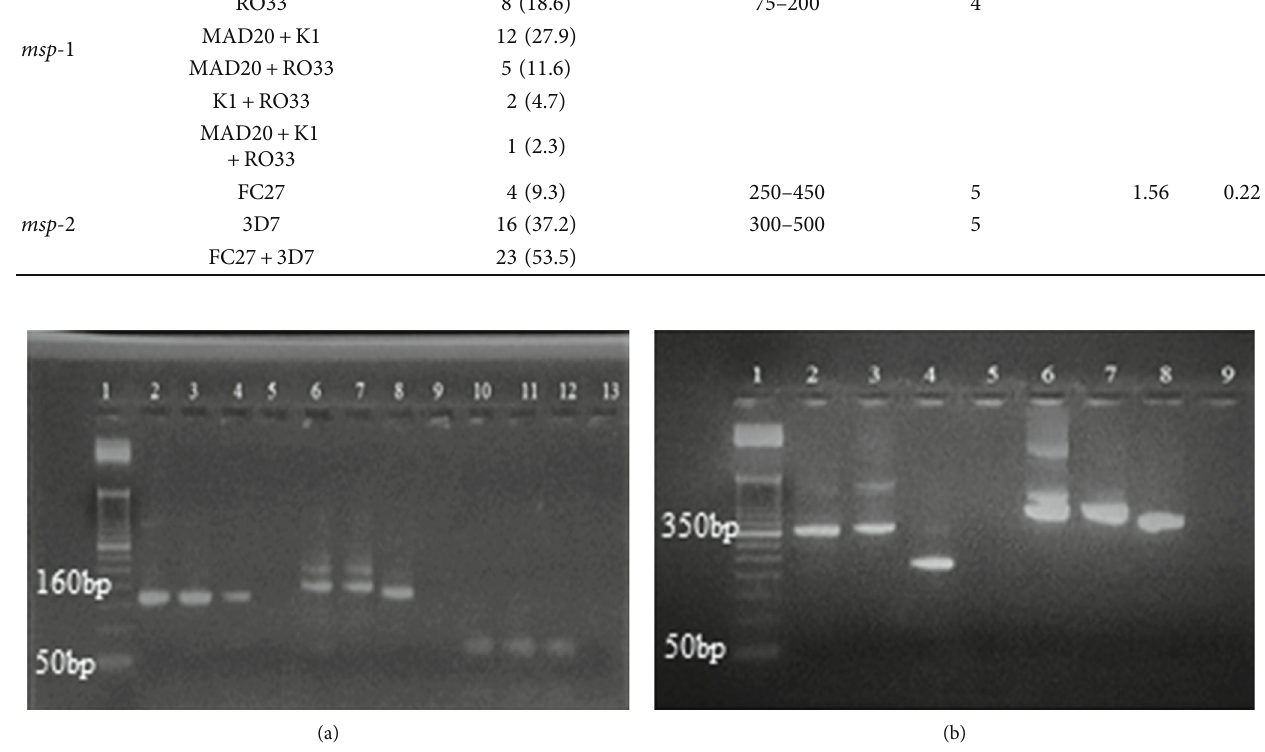
Figure 1: Gel electrophoresis of MSP allelic families. (a) Alleles of the msp -1 gene showing lane 1 (L1) 50bp DNA ladder; positive samples: L2 and L3 for MAD20 (160bp), L6 and L7 for K1 (200bp), and L10 and L11 for RO33 (75 bp); positive control: L4, L8, and L12; negative control: L5, L9, and L13. (b) Alleles of the msp -2 gene showing lane 1 (L1) 50bp DNA ladder; positive samples: L2 and L3 for FC27 (350bp) and L6 and L7 for 3D7 (400bp); positive control: L4 and L8; negative control: L5 and